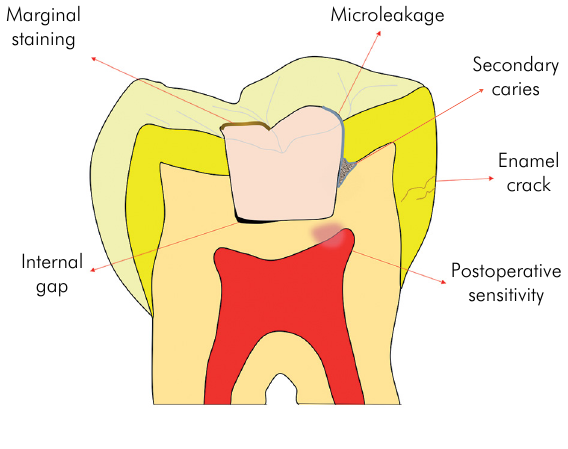
Figure 1. Schematic signs and symptomscaused by polymerization shrinkage (adaptated from Tantbirojn et al. 16